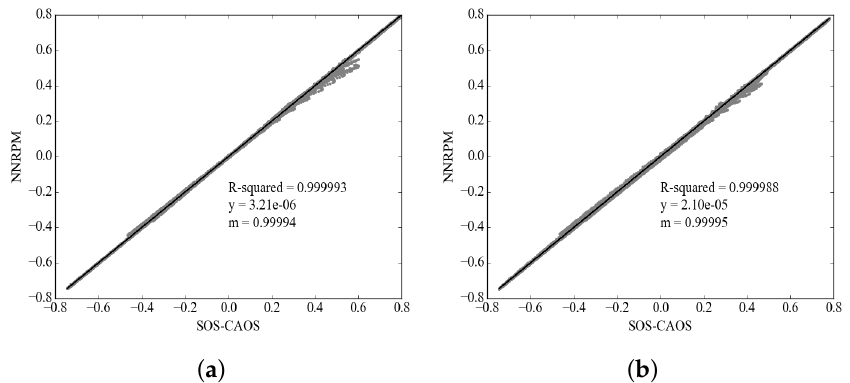
Figure 4. Linear regression between the true reflectance values generated by SOS-CAOS and those predicted by NNRPM for elements ( a ) M 22 /M 11 and ( b ) M 32 /M 11 at 555 nm for 1000 Halton sequences.